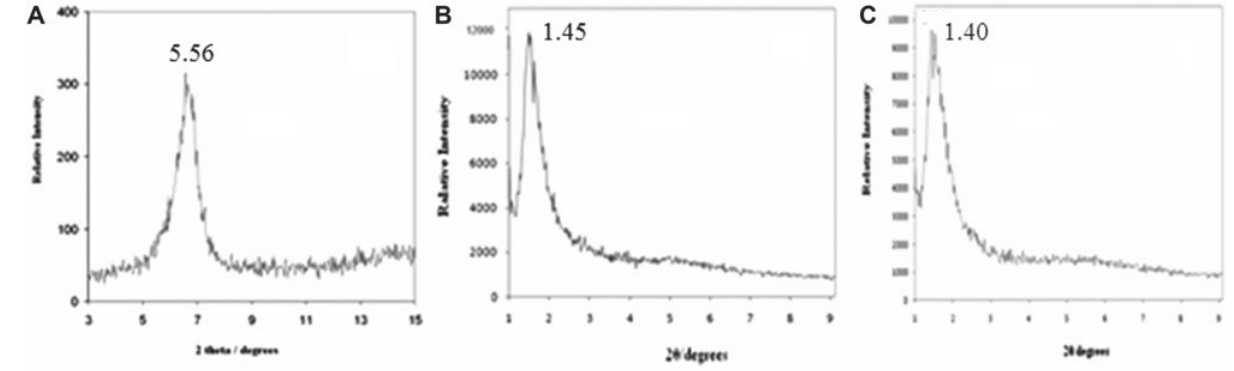
Figure 2 XRD patterns of organoclay (A), and PA-nanocomposite fi lms 3a (B) and 3b (C).